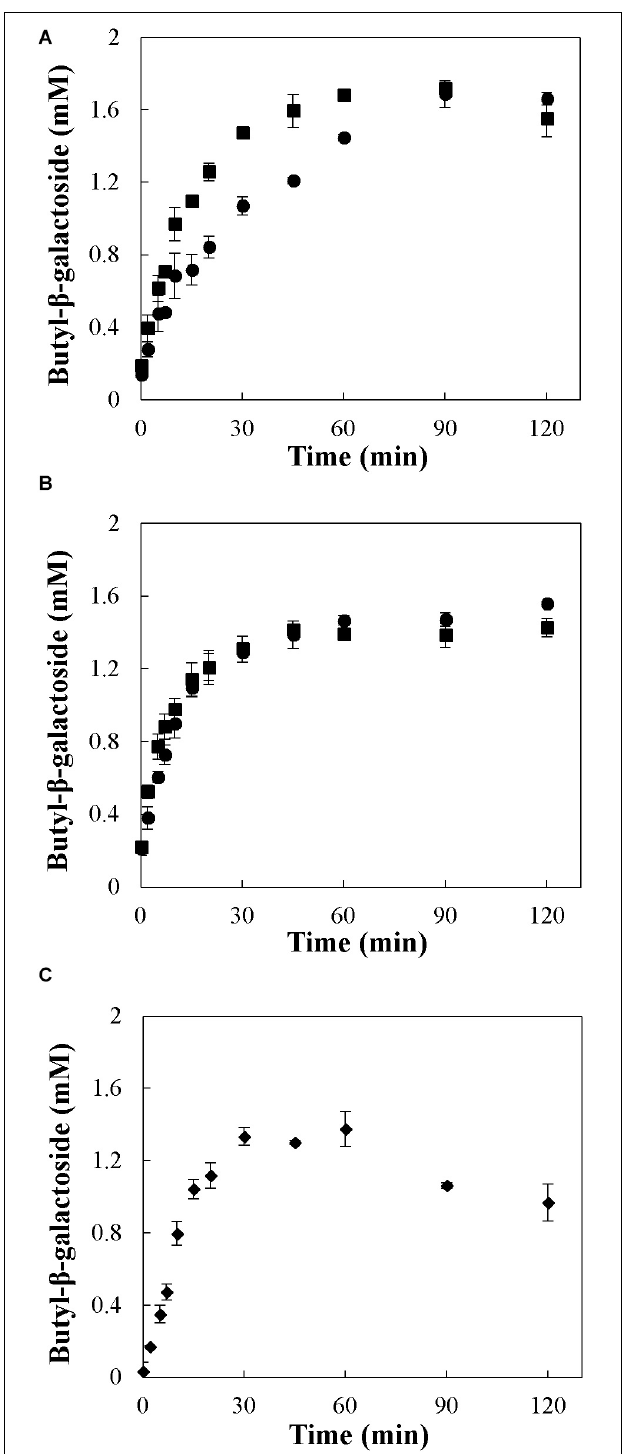
FIGURE 3 | Synthesis of butyl- β -galactoside with immobilized β -galactosidase from A. oryzae in the ternary system acetone/1-butanol/aqueous solution. Reactions were conducted at 30 ◦ C and 30/50/20% (w/w) of acetone/1-butanol/aqueous solution (5 g L − 1 of lactose). Enzyme was immobilized in panels (A) GA, (B) Am-GA, and by CLAGs (C) . Circles: standard agarose; squares: fine agarose.